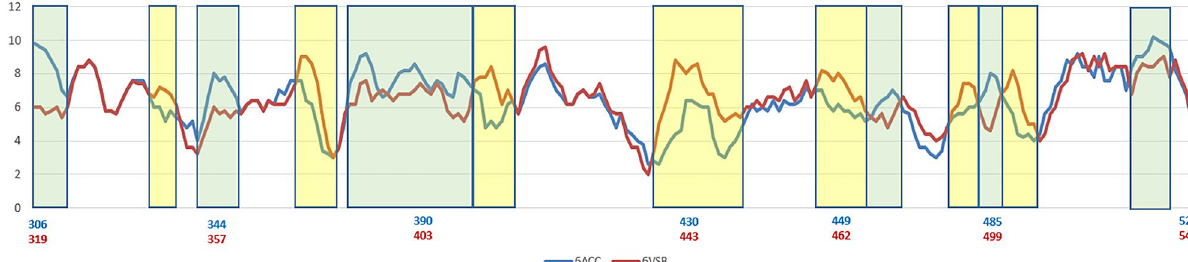
Figure 2. The numbers of folding variations in PFVM between 6ACC-A-306-527 for SARS-CoV and 6VSB-C- 319-541 for SARS-CoV-2. The horizontal coordinate is the sequence position, and the longitudinal coordinate is the number of folding shapes, i.e., number of PFSC letters. Blue curve represents the change of numbers of folding variations along sequence for 6ACC; red curve for 6VSB. Yellow blocks indicate the ranges with more variation in SARS-CoV, whereas green blocks indicate more variation in SARS-CoV-2.